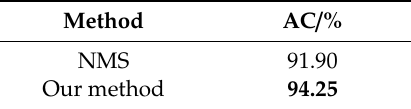
Table 5. Results of different methods.